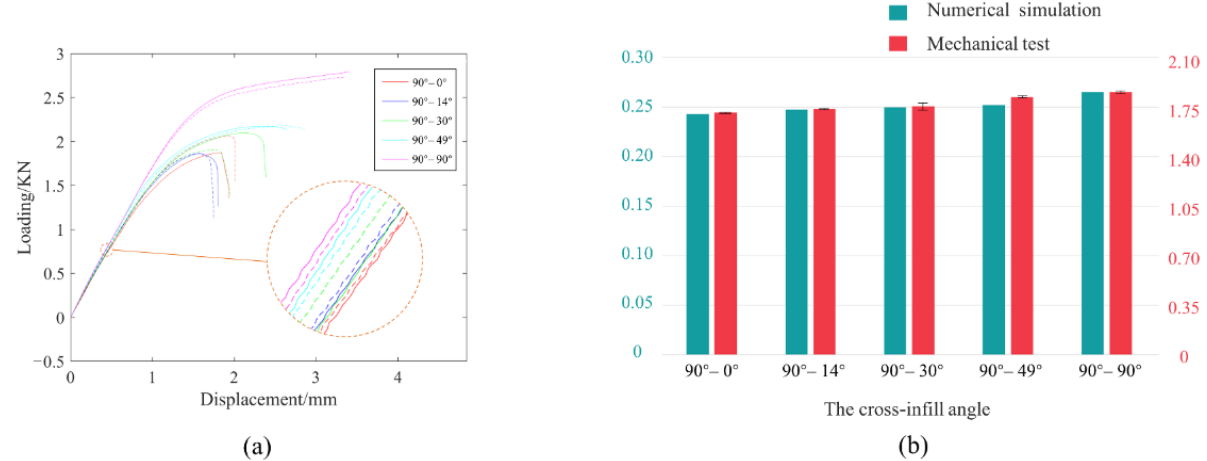
Figure 8. Mechanical test results and their comparison with numerical simulations. ( a ) The force- displacement curves of the mechanical tests. ( b ) The comparison between numerical simulation and mechanical test results.